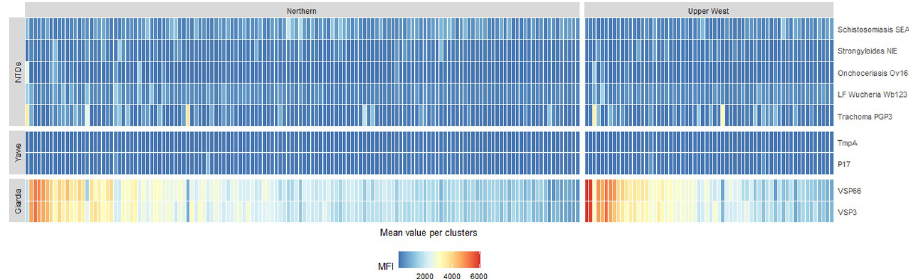
Fig 4. Arithmetic mean MFI values per cluster by